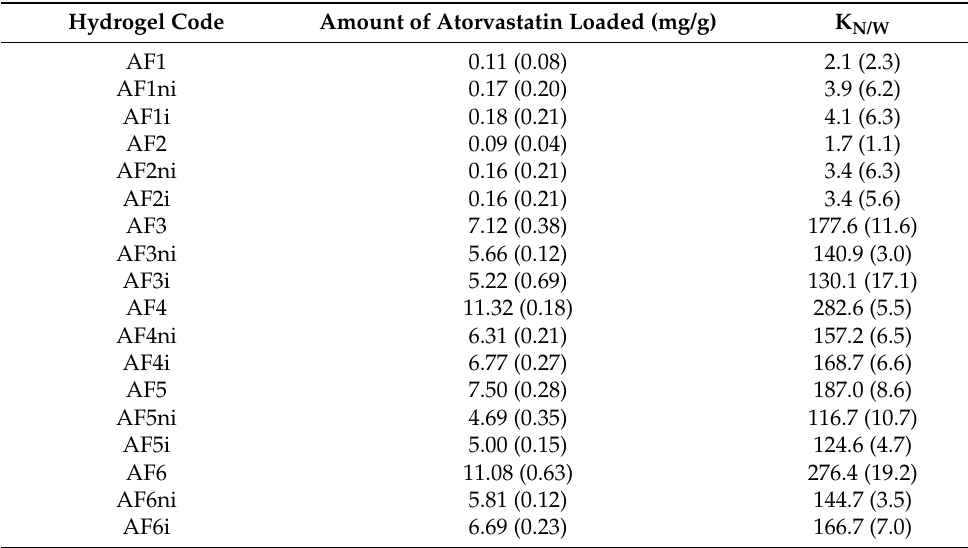
Table 2. Amounts of atorvastatin loaded by each hydrogel, and the K N/W values calculated (mean value and in parenthesis standard deviations). Codes as in Table